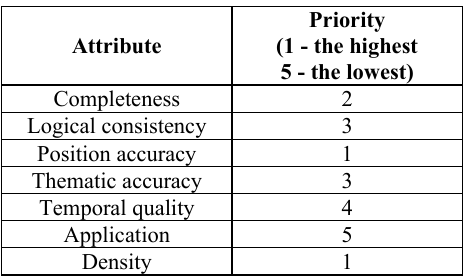
Table 2. Proposed priority list of attributes of the point clouds in the BIM modeling